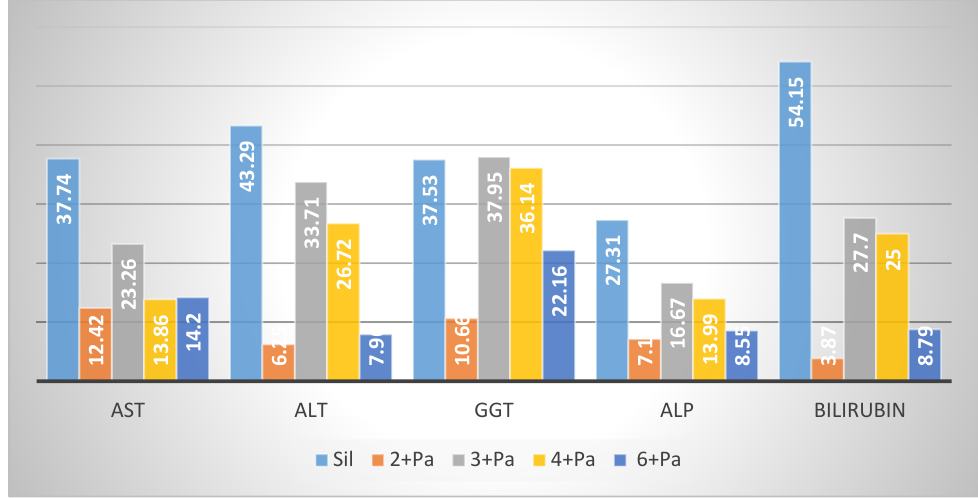
Figure 2. Effect of compounds 2–4 , 6 on liver serum biochemical parameters AST, ALT, GGT, APL and bilirubin (% reduction).